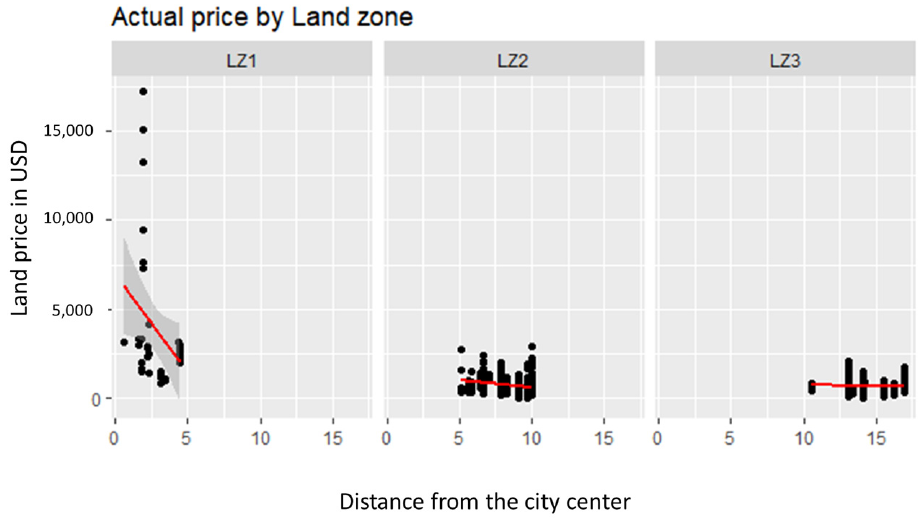
Figure 9. Actual urban land prices per m 2 in USD against distance from the center in kilometers and categorized by land zone.